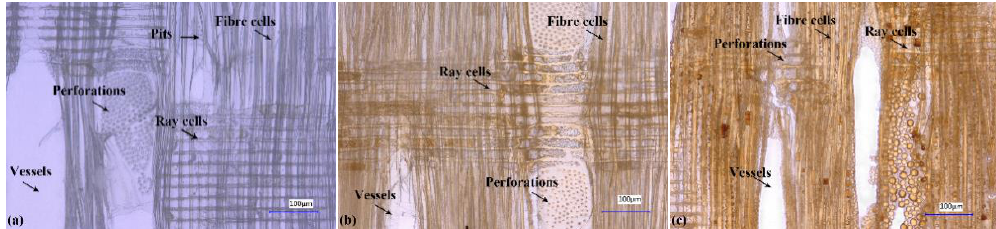
Figure 1. Digital microscope images of ( a ) control wood ( b ) furfurylated wood with 23% weight gain percent ( c ) furfurylated wood with 69% weight gain percent.